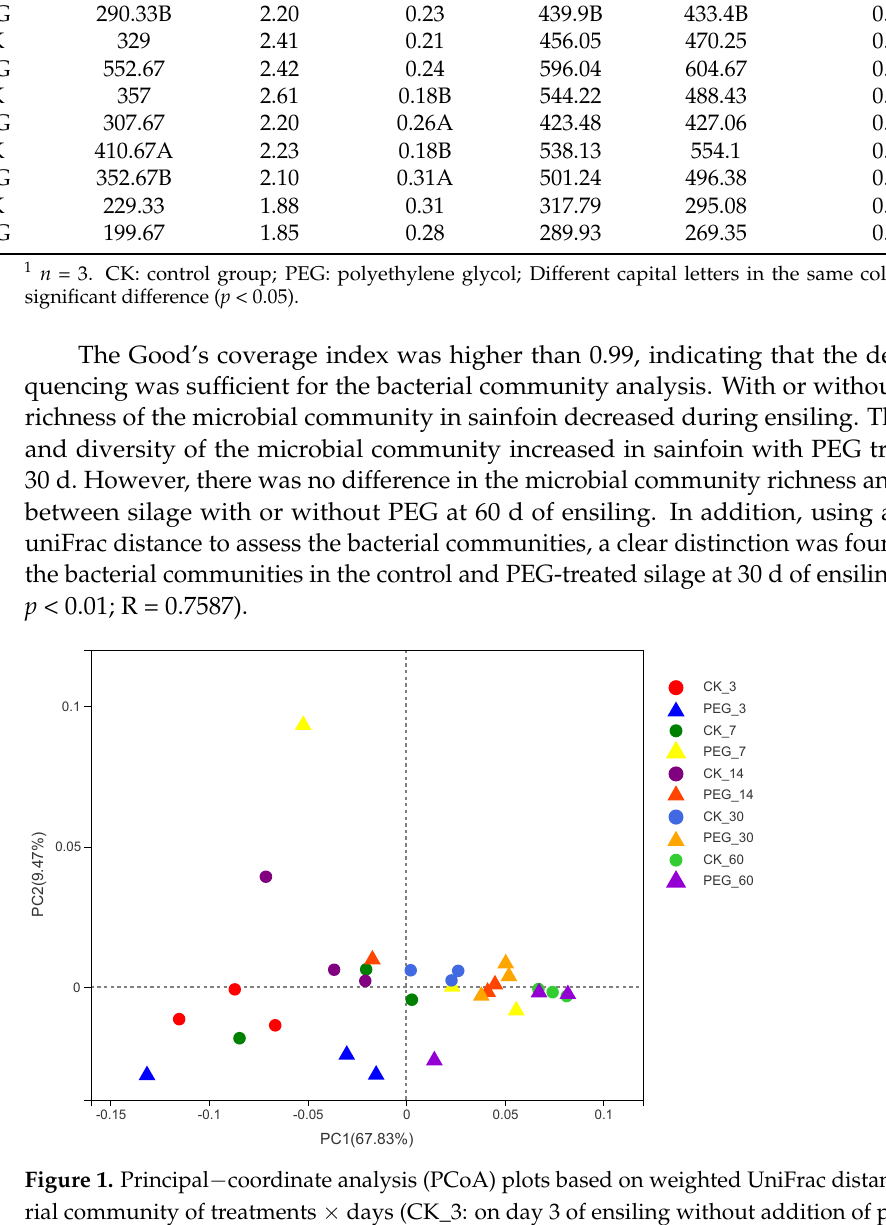
Table 3. Alpha diversity of bacterial community of sainfoin silage 1 .